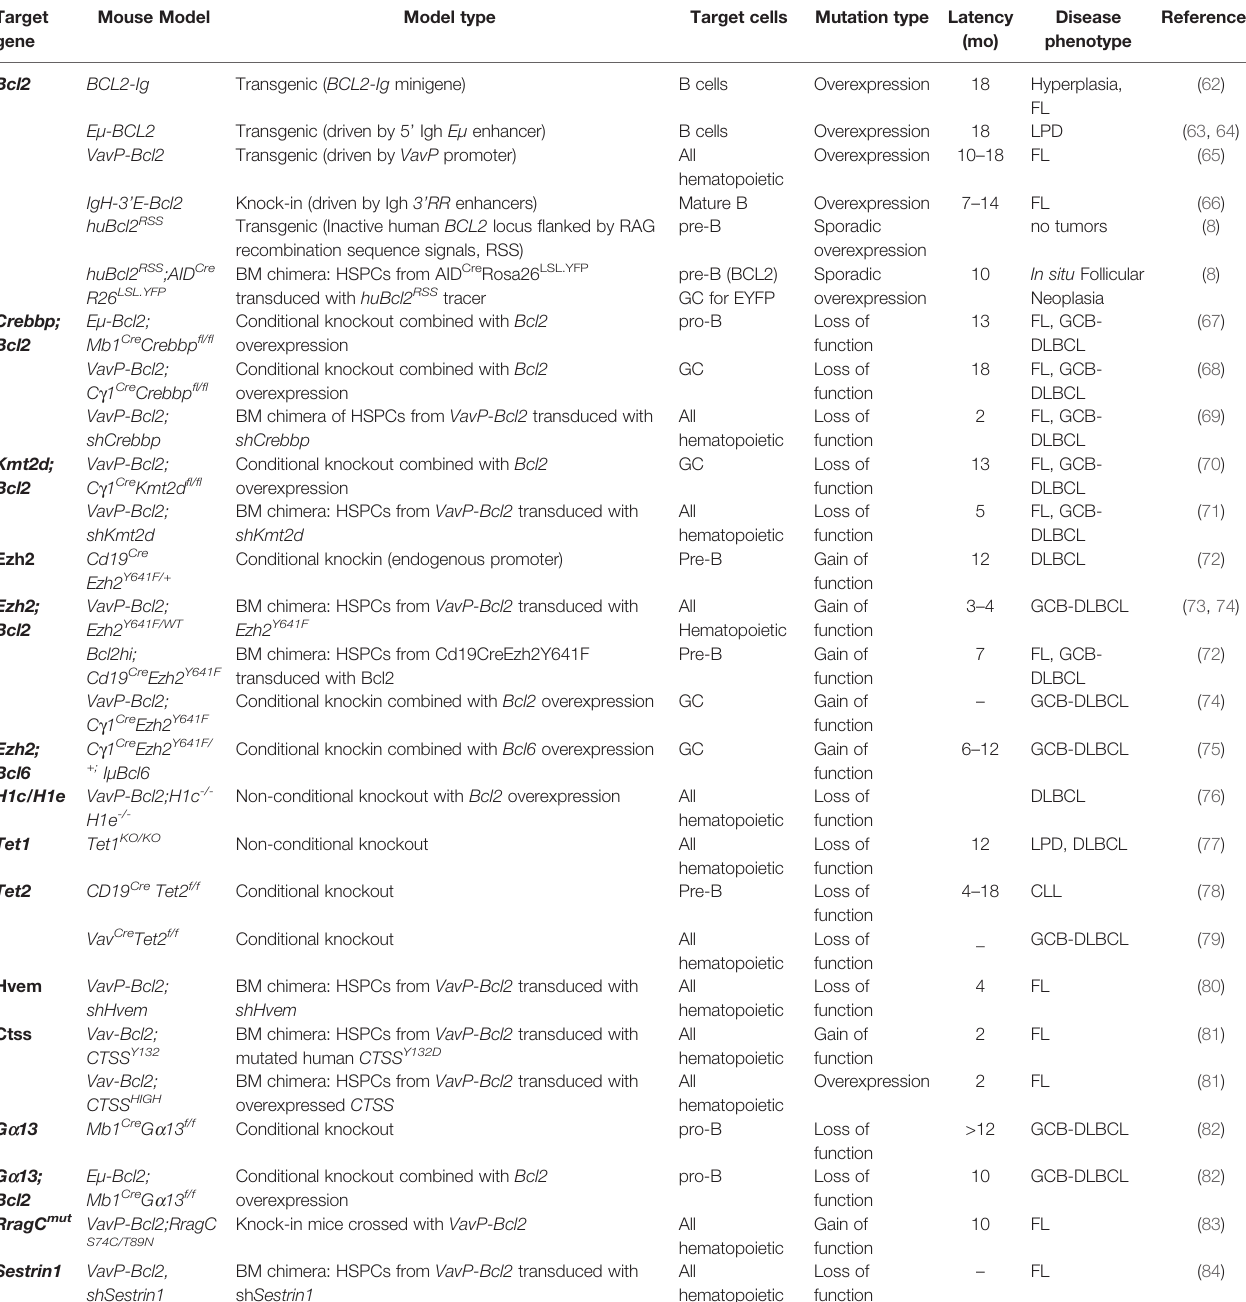
TABLE 1 | Relevant mouse models of follicular lymphoma and germinal center B cell diffuse large B cell lymphomas. Target